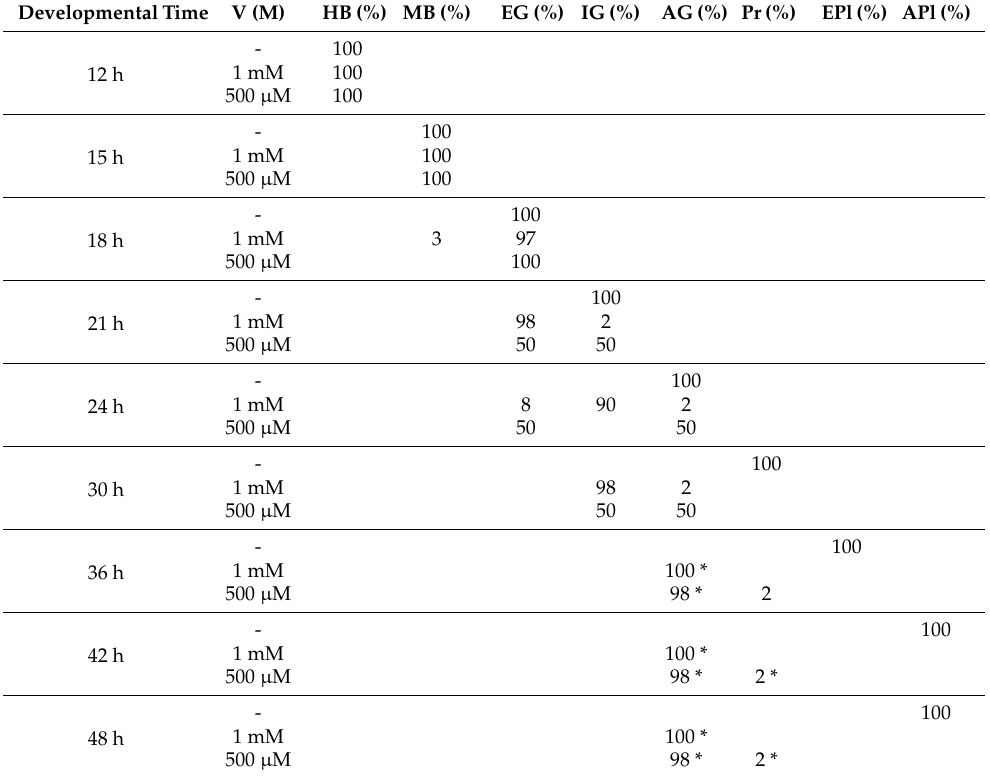
Table 1. Frequency of embryonic stages detected at different V-concentrations and different develop- mental times. Developmental stages are indicated as HB (hatching blastula); MB (mesenchyme blas- tula); EG (early gastrula); IG (intermediate gastrula); AG (advanced gastrula); Pr (prism); EPl (early pluteus); and APl (advanced pluteus). * Altered phenotypes. Data are presented as the mean of triplicate experiments ( n =